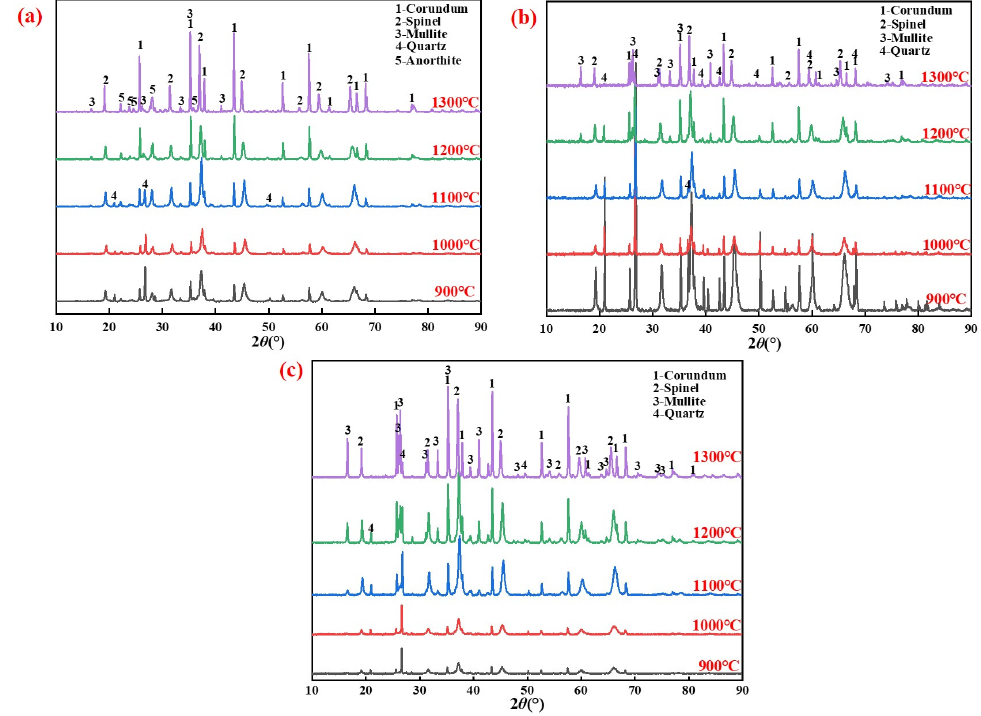
Figure 3. XRD patterns of specimens prepared from different silicon sources after sintering at 900–1300 °C: ( a ) Fly ash; ( b ) Silica dust; ( c ) Gangue. The major crystalline phases detected were Al 2 O 3 (corundum), 3Al 2 O 3 ·2SiO 2 (mullite), and MgAl 2 O 4 (spinel).